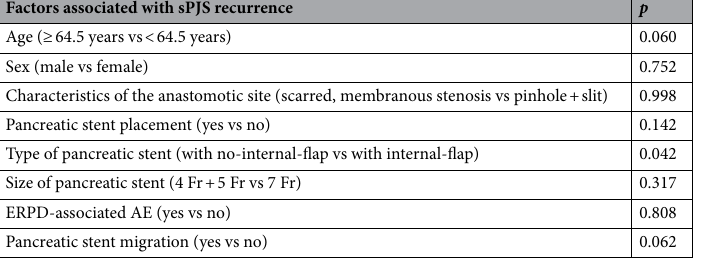
Factors associated with sPJS